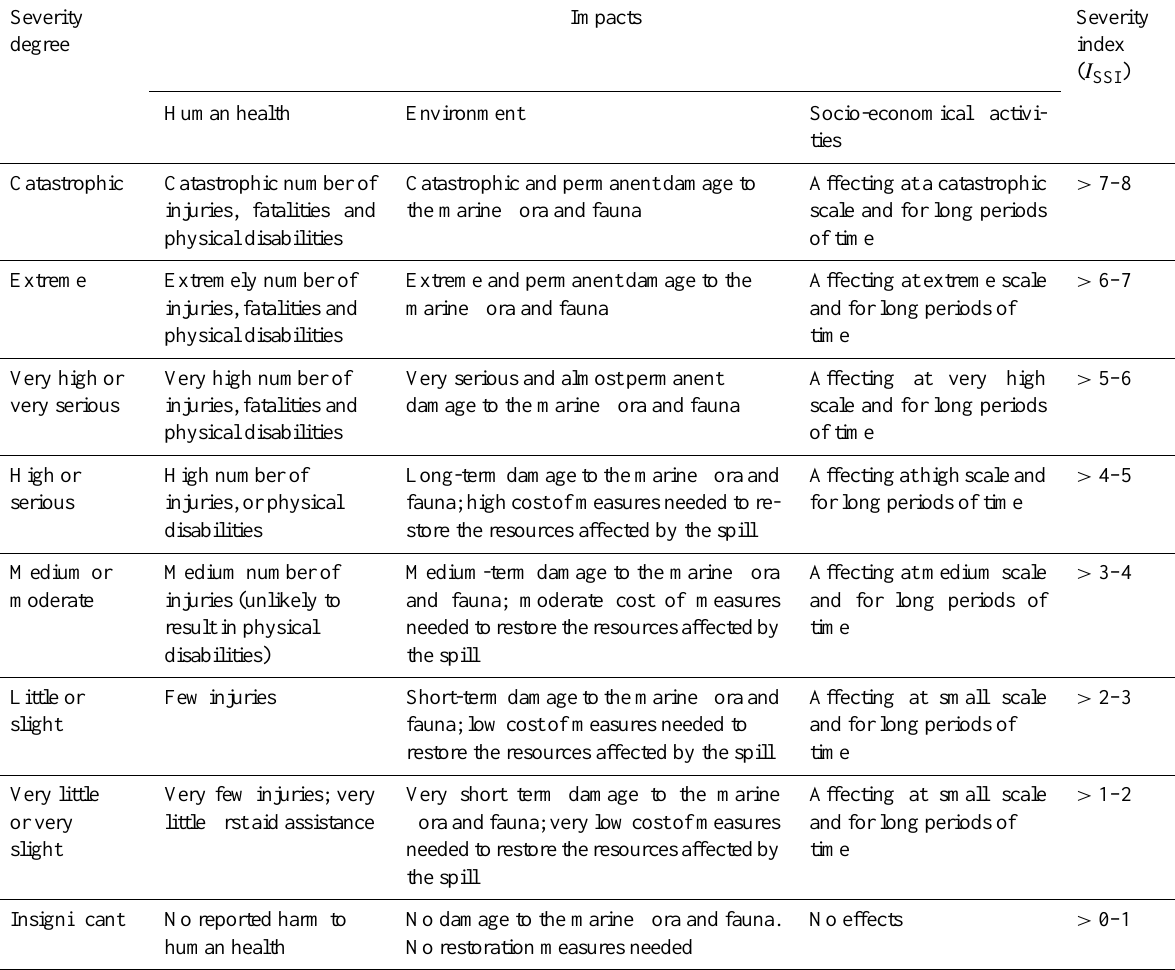
Table D1. Classification of severity of ship incidents and correspondence between severity and index of